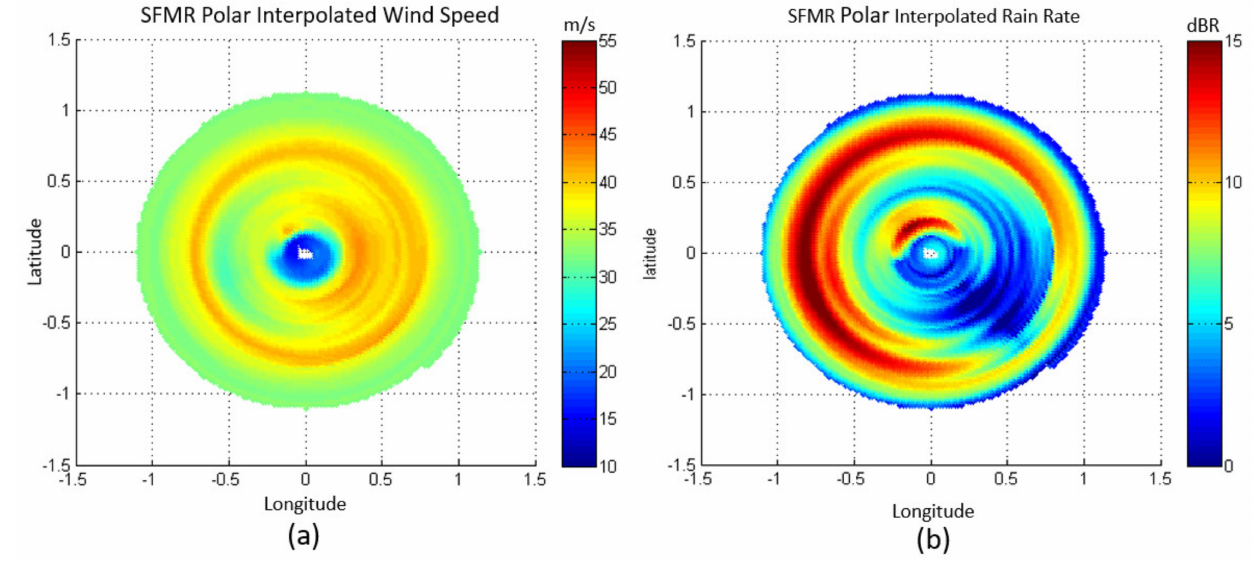
Figure A1. SFMR polar modeled ( a ) WS m/s and ( b ) RR in dBR. With the HIWRAP in-flight calibration, variations in wind speed in the order of ± 2 m/s at 30 m/s produce maximum errors of 0.3 dB. Since high windspeeds saturate the HIWRAP-normalized radar cross-section σ 0 measurement, calibration becomes more accurate as HIWRAP approaches saturation. For HIRAD, small changes in the rains and the wind fields are averaged out in the fitting, where mislocated rain events are corrected during the sorting. This was validated in simulation, where given SFMR along-track measurements of wind and rain, one can perturb the rain rate measurement by injecting a 5 mm/h random Gaussian noise and shift the rain rates up to 20 km, varying the maximum rains and accurately retrieving the original